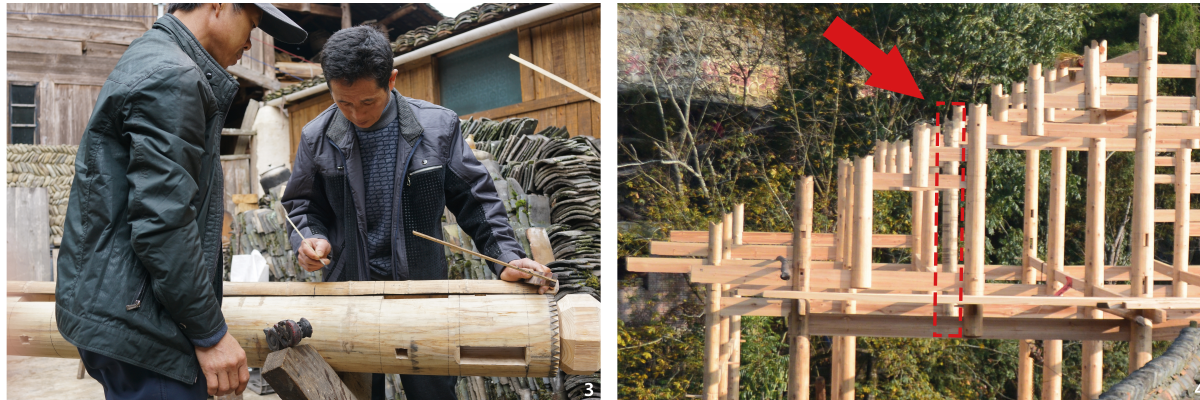
Figure 3 Marking ink lines according to the dimension pole, Dali village, 2016 (Source: Congcong Ren). Figure 4 Short column marked with numerous ink lines, Dali Villiage, 2016 (Source: Congcong